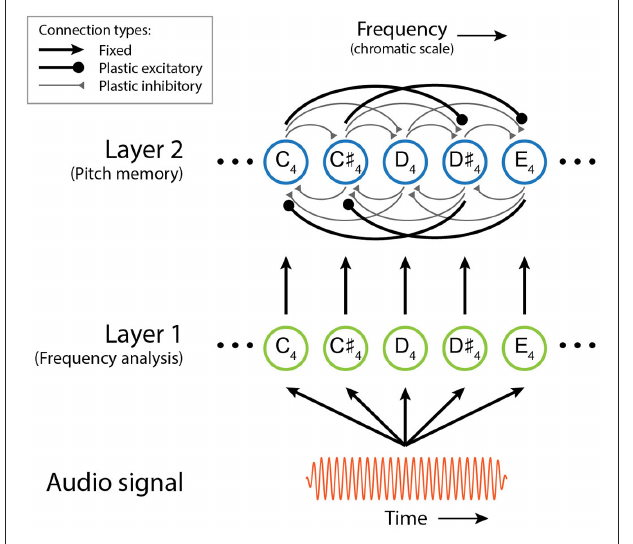
FIGURE 1 | Schematic of the dynamical model of short-term pitch memory. The colors and line widths used for different connection types are only for visual distinction and do not indicate their relative strengths.